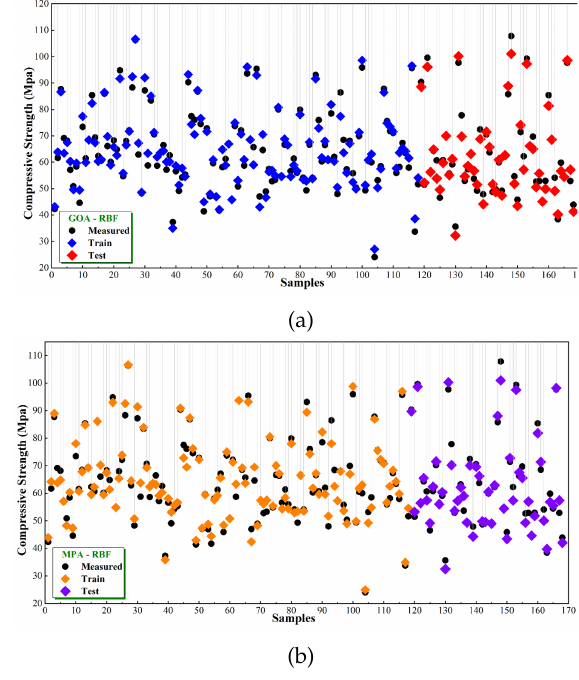
Fig. 6. The correlation plot of measured and predicted values of compressive strength with the RBF-MPA model